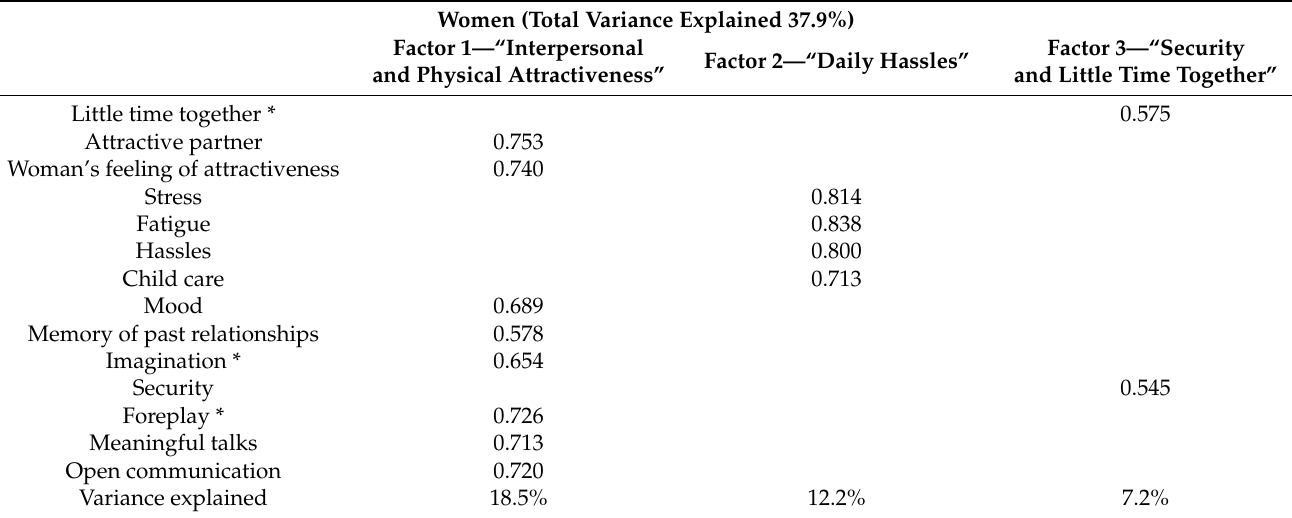
Table 2. Factor analysis on what influences the sexual desire of women, by